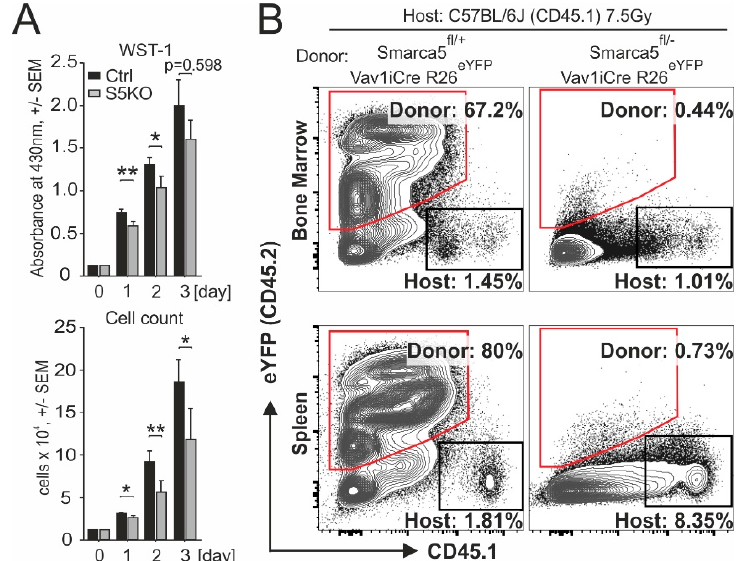
Figure 3. Proliferation of AML and progenitor cells upon Smarca5 gene deletion. ( A ) Proliferation of S5KO clone #D7 and control cells analyzed by WST-1 assay. Mean ± SEM of formazan absorbance (top) and cell count (bottom) (pentaplicates). Student’s t-test, p < 0.05 *, p < 0.01 **. ( B ) Flow cytometry analysis of donor (CD45.2) and host (CD45.1) derived hematopoietic cells at 14 days following the transplantation of donor fetal liver cells into lethally (7.5 Gy) irradiated host animals. Donor (red trapezoid) and host-derived (black rectangles) bone marrow cells (upper dot plots) and splenocytes (lower dot plots) were distinguished by the expression of yellow fluorescent protein (eYFP) or surface variant of CD45. Control mice: Smarca5 fl /+ Vav1iCre R26 eYFP ; Smarca5 mutant mice: Smarca5 fl / fl Vav1iCre R26 eYFP . Data are representative of repeated experiments.